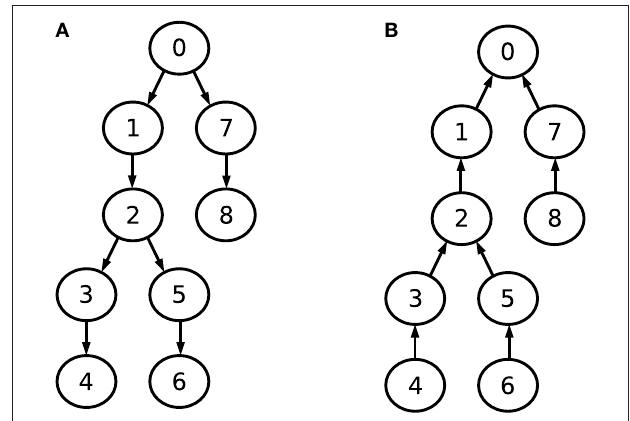
FIGURE 4 | Data dependency graphs for (A) Gaussian elimination and (B) back-substitution of an LSE with a matrix as depicted in Figure